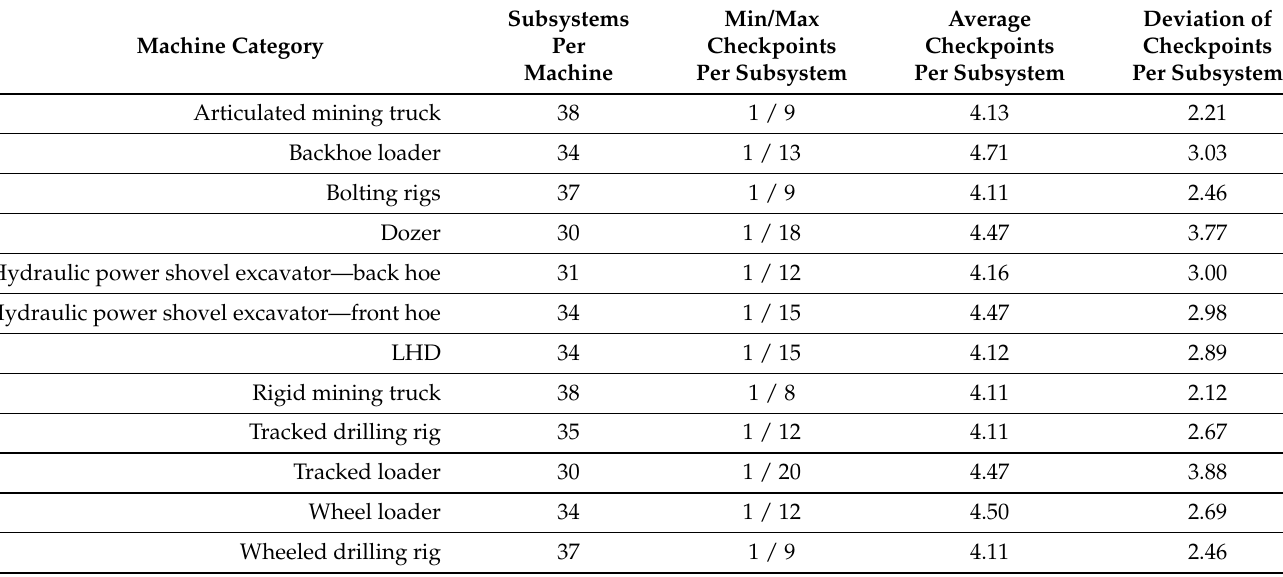
Table 1. Number of measures/observations that need to be collected per subsystems (assumption: one measure/observation per